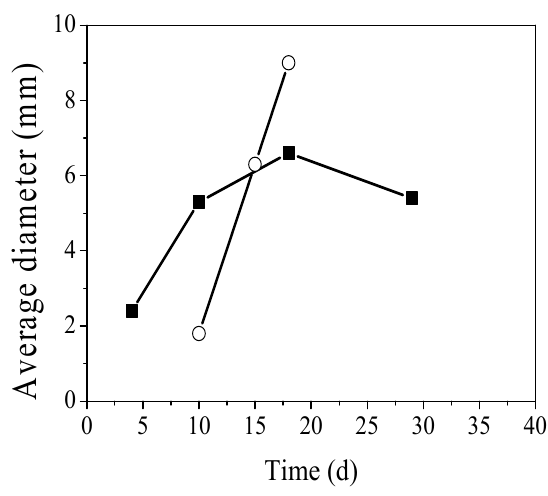
Time (d) Figure 2. Average diameter of biomass in SBR I ( ○ ) and SBR II ( ■ ). Figure 2. Average diameter of biomass in SBR I ( ○ ) and SBR II ( ■ ). Figure 2. Average diameter of biomass in SBR I ( ) and SBR II ( (cid:4) ). (cid:35)